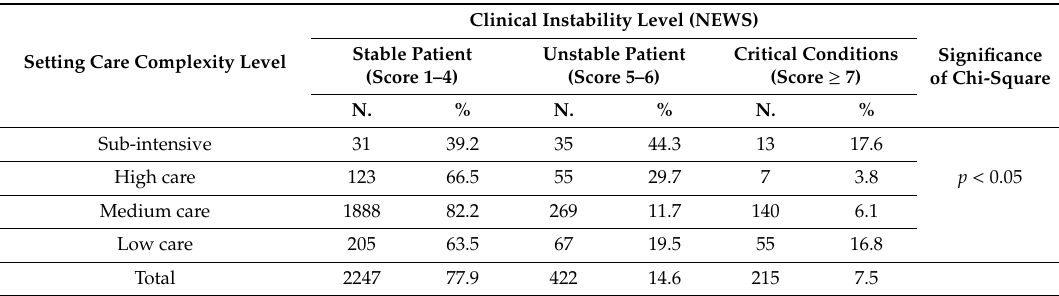
Table 7. Distribution of clinical instability levels by setting care.